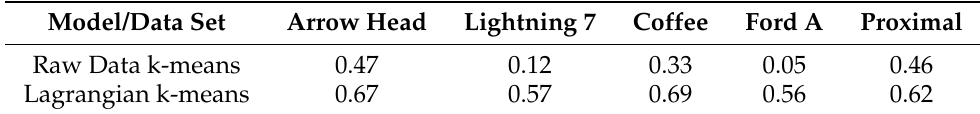
Table 1. Silhouette evaluation of Lagrangian representation using k-means.